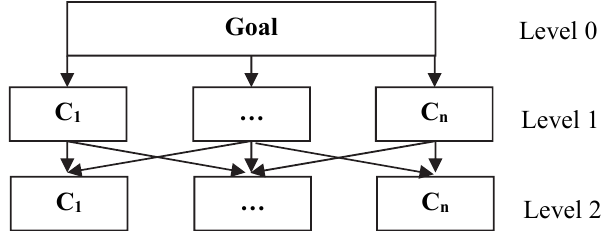
Fig. 2. A multi-level hierarchical structure for location